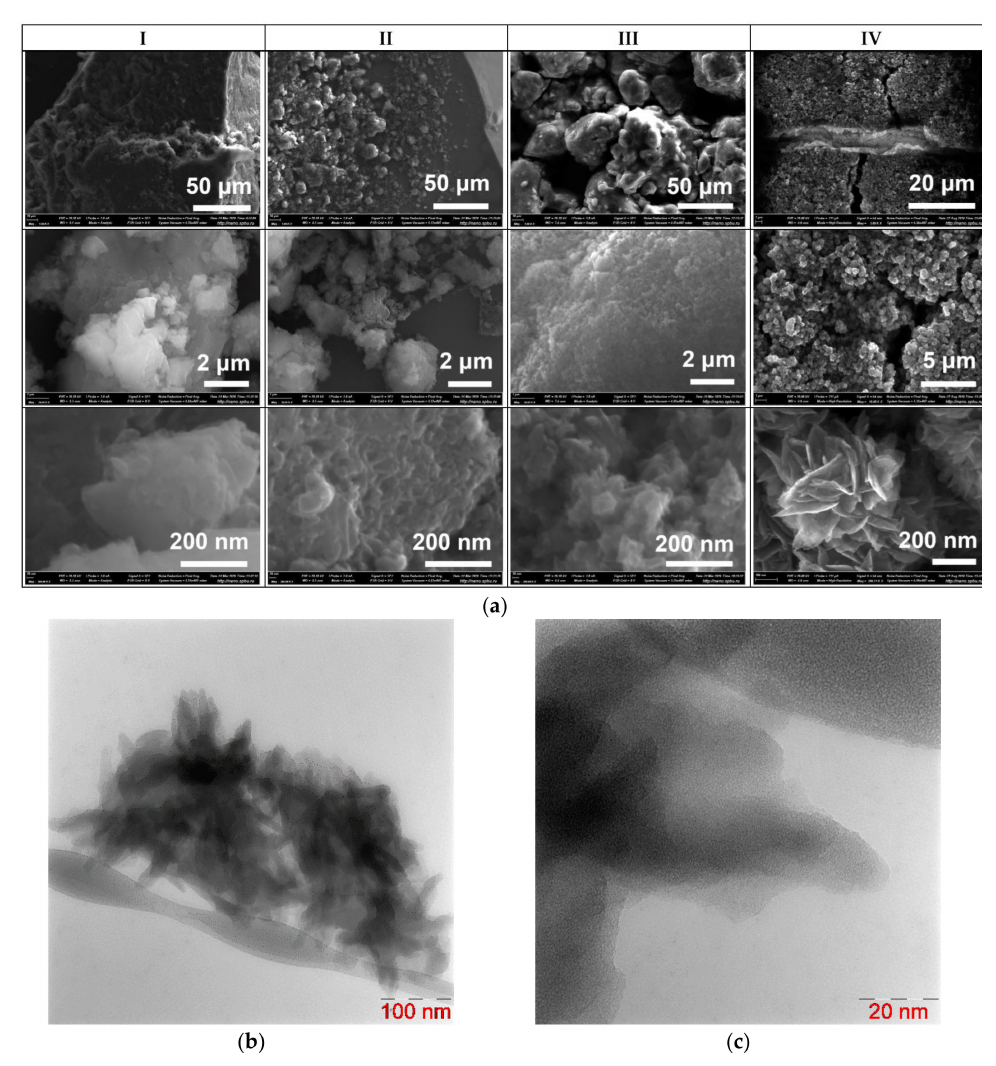
Figure 2. ( a ) SEM images of electrode materials I-IV, TEM images of IV at ( b ) lower magnification and ( c ) higher